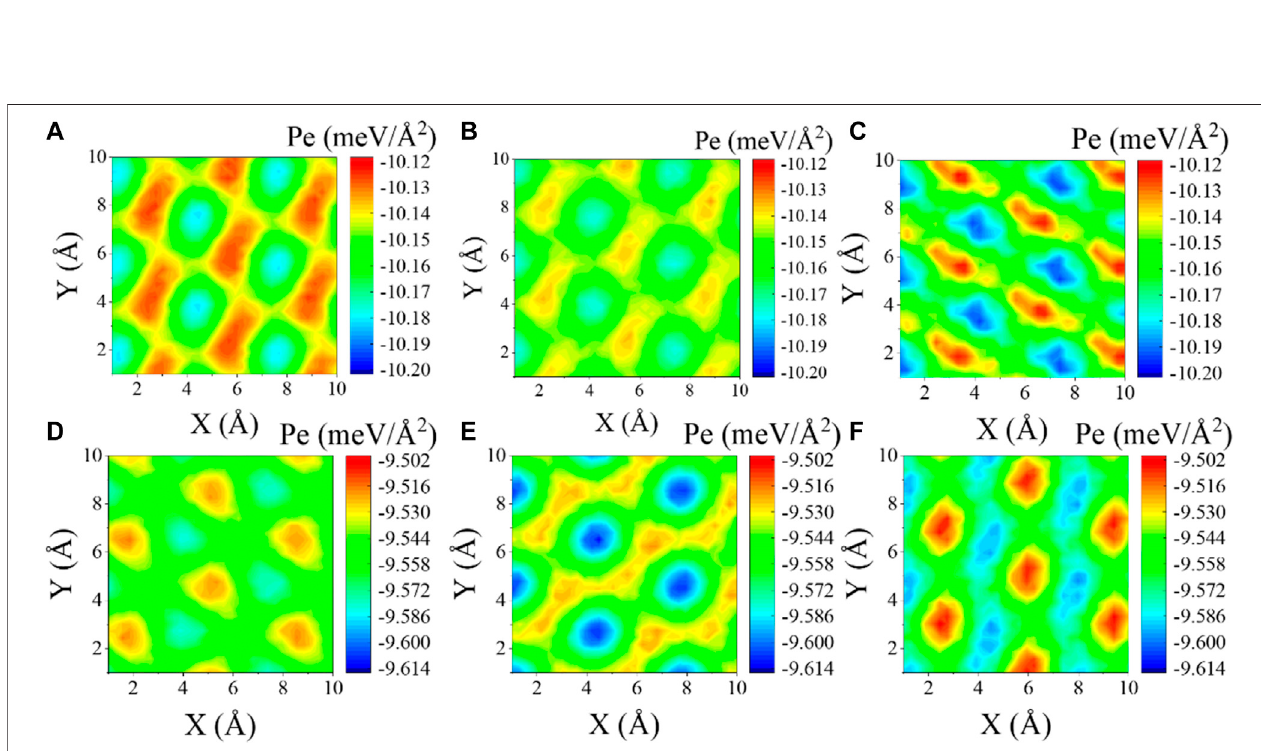
FIGURE 6 | Effective interaction potential energy surface of the heterostructure. (A – C) PES of the α -Te/MoS 2 heterostructure with different rotation angles, where (A) θ = 0 ° ; (B) θ = 15 ° ; and (C) θ = 30 ° . (D – F) PES of the α -Te/NbSe 2 heterostructure with different rotation angles, where (D) θ = 0 ° ; (E) θ = 15 ° ; and (F) θ = 30 ° .